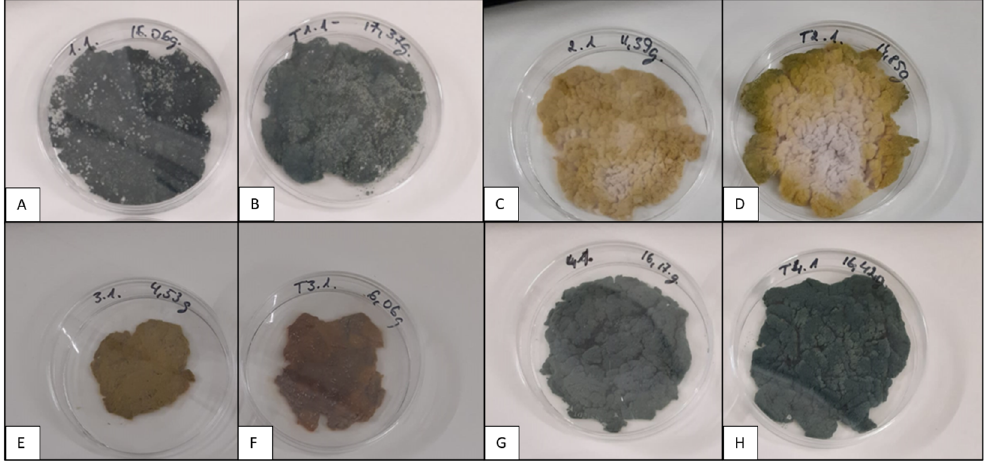
Figure 2. The morphological features of T. asperellum biomass (cultivated in fl asks) depending on the composition of the culture medium after fi ve days. Individual picture designation regarding